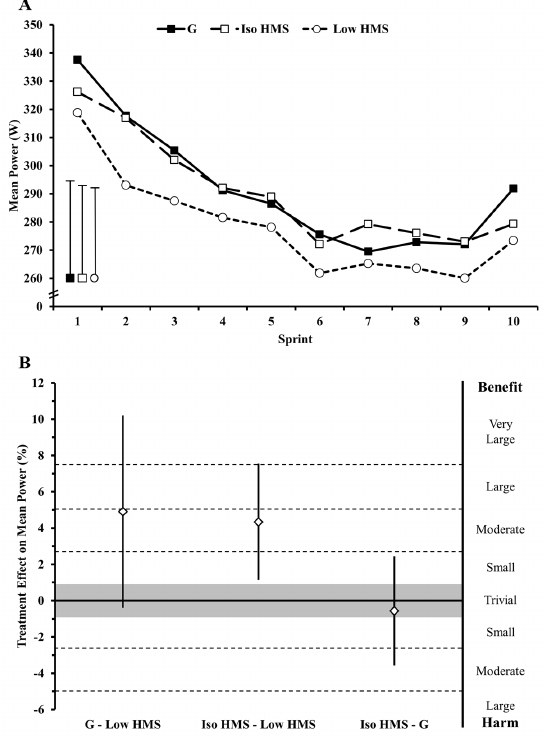
Figure 2. Effect of a hydrothermally-modified starch supplement on cycling performance. ( A ) Mean sprint power for each sprint of the performance test. Bars represent the mean standard deviation for all repeated sprints; and ( B ) mean effects (%) of treatment condition on mean sprint power. Bars represent the 90% confidence interval. G, a sucrose/glucose supplement; Iso HMS, an isocaloric dose (relative to G) of a hydrothermally-modified starch; Low HMS, low dose of a hydrothermally-modified